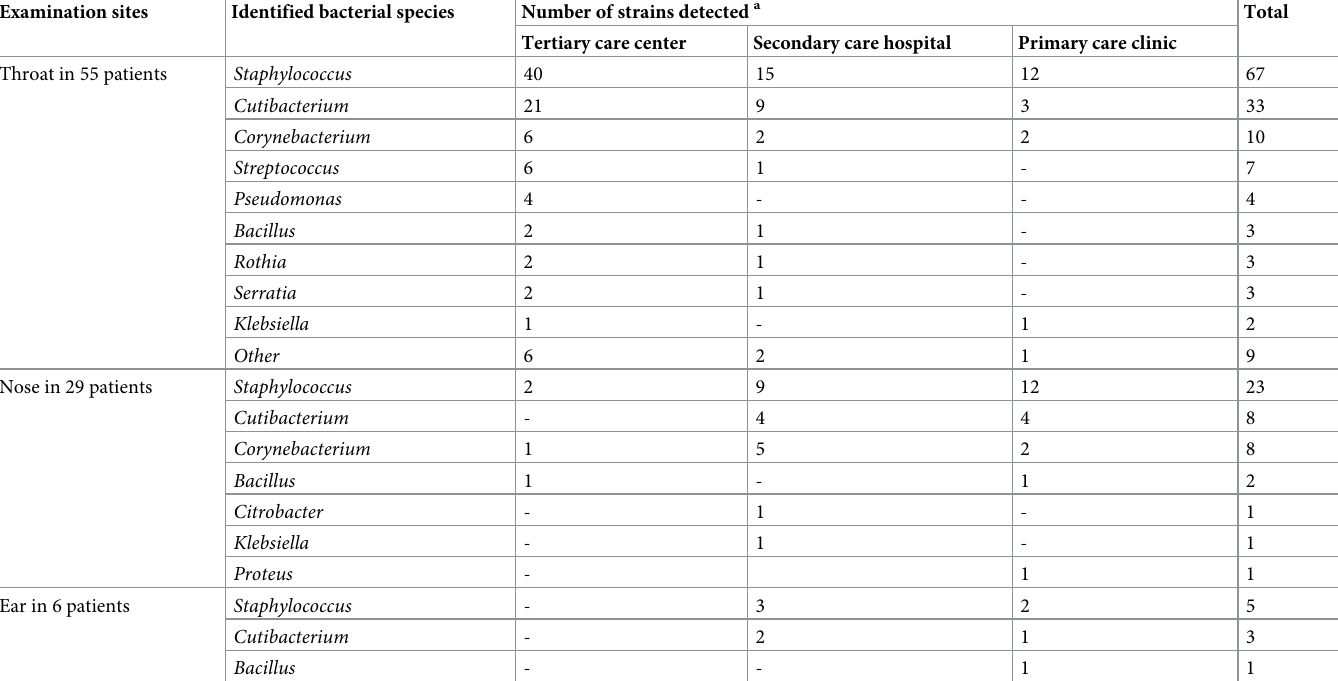
Table 3. Bacterial species and location of isolation.